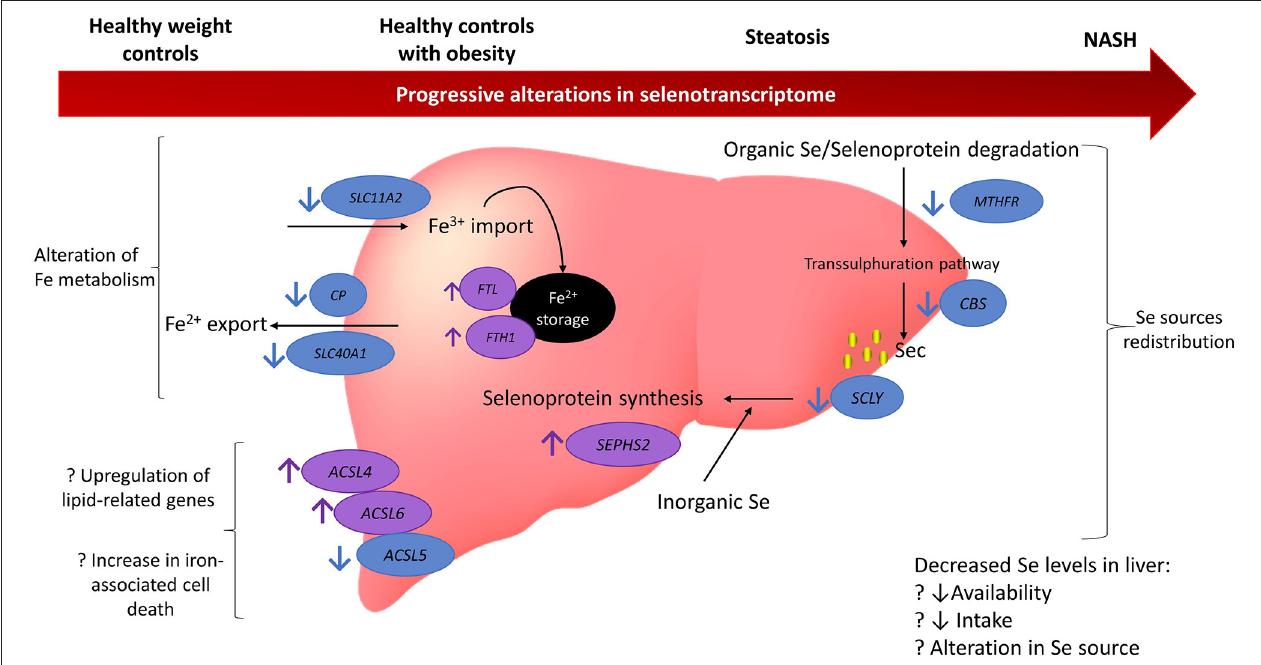
FIGURE 5 | Model summarising the findings from gene expression analysis of 164 genes related to selenium and selenoproteins. Findings suggest there may be a redistribution in selenium sources with a reduction in organic selenium degradation via the transsulphuration pathway and an increase in the metabolism of inorganic selenium. Iron metabolism may also be disturbed with an increase in iron storage and promotion of factors related to iron-associated cell death. There may be several reasons for these alterations and they appear to be progressively altered as NAFLD deteriorates. Blue circles and arrows indicate genes down-regulated in NAFLD compared to controls (either healthy weight or obesity) and the purple circles and arrows indicate genes up-regulated in NAFLD compared to controls. Question marks indicate hypothesised reasons for alterations that cannot be fully tested in the current study. MTHFR, methylenetetrahydrofolate reductase; CBS, cystathionine beta-synthase; SCLY, selenocysteine lyase; ACSL5, acyl-CoA synthetase long chain family member 5; ACSL6, acyl-CoA synthetase long chain family member 6; ACSL4, acyl-CoA synthetase long chain family member 4; SCL40A1, solute carrier family 40 member 1; CP, ceruloplasmin; SLC11A2, solute carrier family 11 member 2; Fe, iron; NASH, non-alchoholic steatohepatitis; Se,